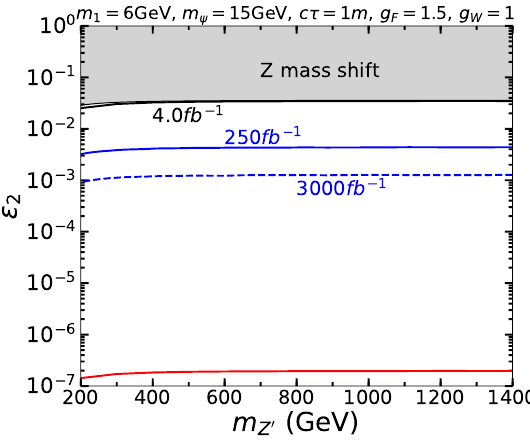
Figure 8 . The integrated luminosity needed at the HL-LHC to probe the parameter region spanned by m Z 0 and (cid:15) 2 . We choose m 1 = 6 GeV, m = 15 GeV, c(cid:28) = 1 m, g F = 1 : 5 and g W = 1. The integrated luminosity needed are (cid:24) 4 : 0 fb (cid:0) 1 (black solid), 250 fb (cid:0) 1 (blue solid), and 3000 fb (cid:0) 1 (blue dashed). The gray shaded region is excluded by the Z mass shift constraint, as given in eq. (3.4). Below the red line, the dark photon production cross section via (cid:15) 1